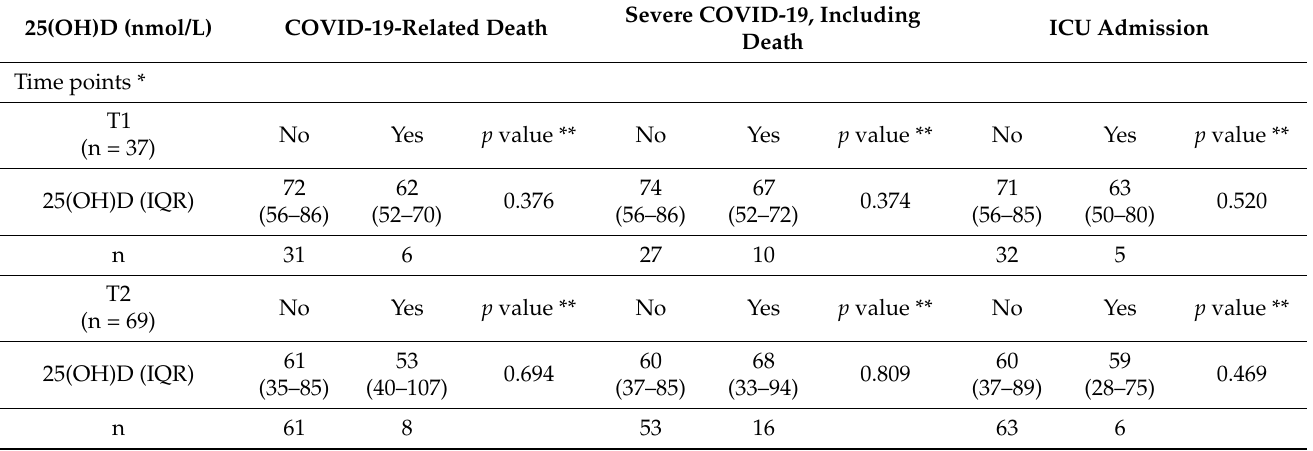
Table 5. Serum 25(OH)D concentrations and COVID-19 severity.